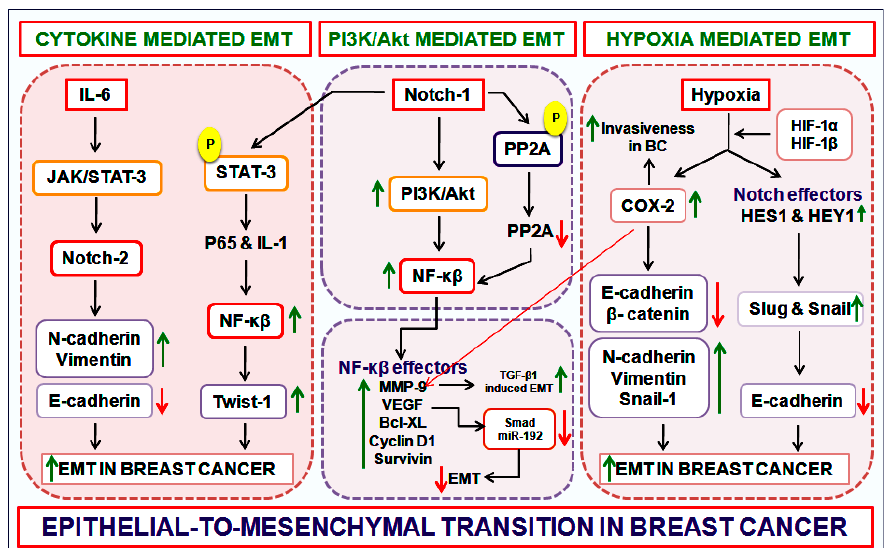
Figure 3. Notch-mediated epithelial–mesenchymal transition (EMT) cross-talk during breast carcinogenesis: The EMT process primarily involves the loss of epithelial markers and gain of mesenchymal markers. Once the cells acquire a mesenchymal phenotype, they first intravasate and later extravasate from the blood vessel to establish a distant metastasis. Post-extravasation, there occurs a reverse process called MET (mesenchymal–epithelial transition) that allows the mesenchymal cells to once again revert back to the epithelial type. The above diagram represents the probable cross-talk between three modules that could drive EMT during breast carcinogenesis; viz., the Notch/Cytokine module, the Notch/Akt module and the Notch/Hypoxia module. Inositol blocks both the activity of Notch and Akt and could serve as a potent therapeutic agent targeting EMT. It must be noted that Notch-mediated EMT via Akt and STAT-3 is mediated primarily by NF- κβ . NF- κβ , nuclear factor-kappa β ; PP2A, protein phosphatase-2A; IL, interleukin; COX-2, cyclooxygenase-2; BC, breast cancer; VEGF, vascular endothelial growth